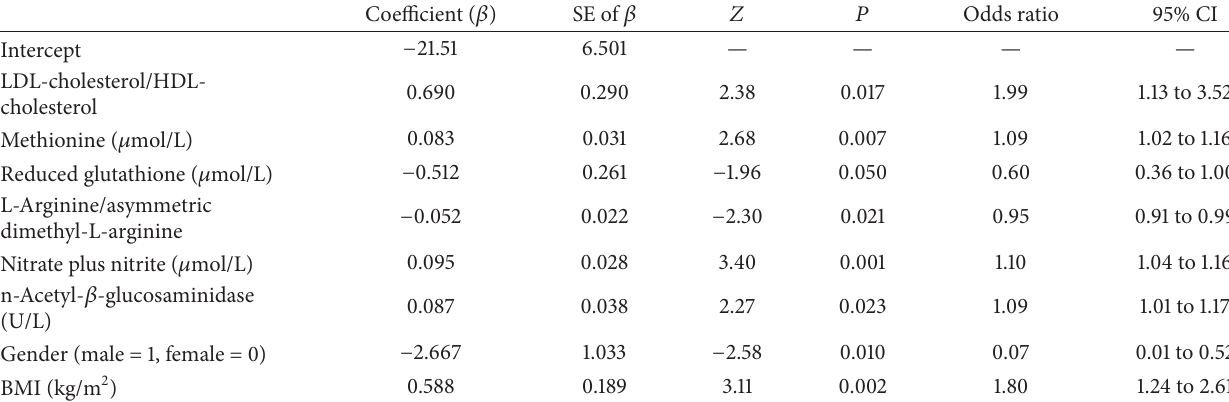
Table 2: Final multiple logistic regression model for coronary artery disease in patients with type 2 diabetes ( 𝑛 = 96 ). Coefficient ( 𝛽 )